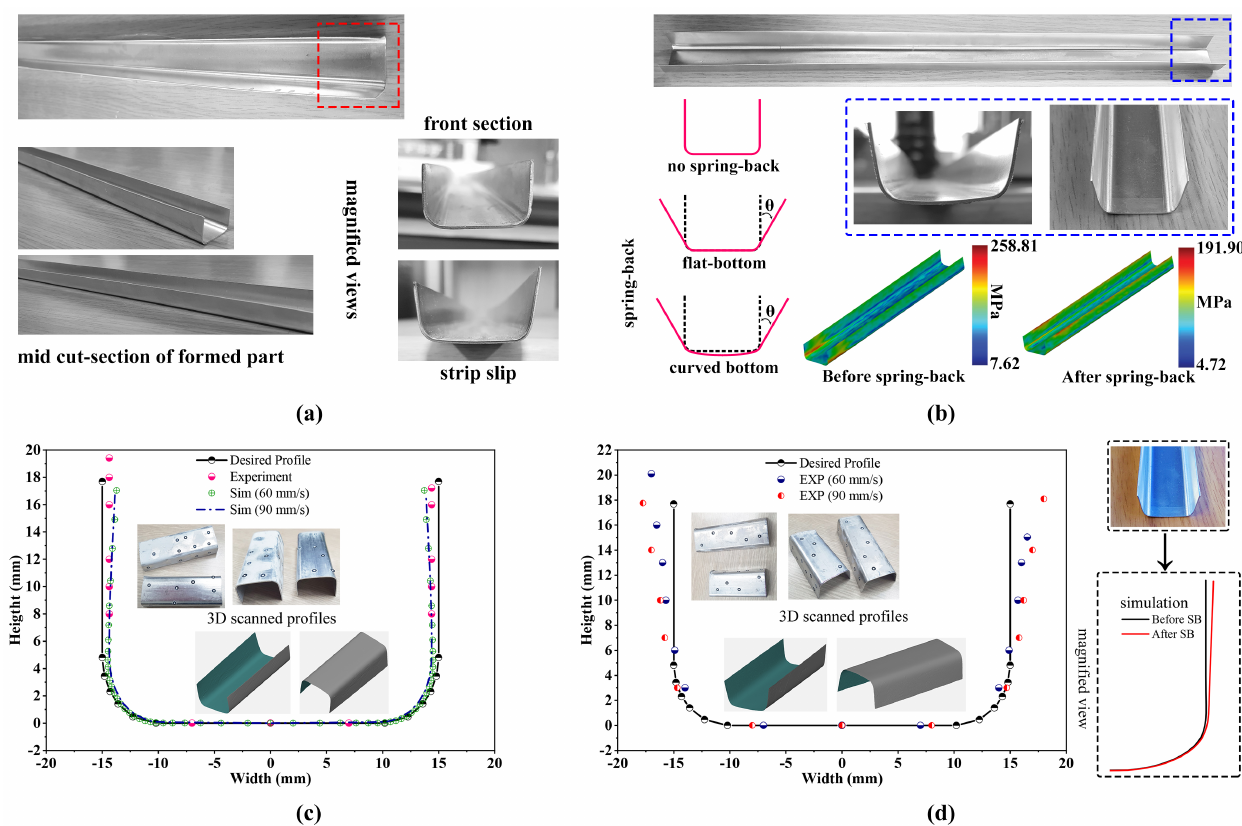
Figure 8. ( a ) Formed U-profile at real-time experiment; ( b ) spring-back of U-profile; ( c ) deformed 2D U-profile coordinates of front section from experiment and simulation; ( d ) deformed 2D U-profile coordinates of back section from